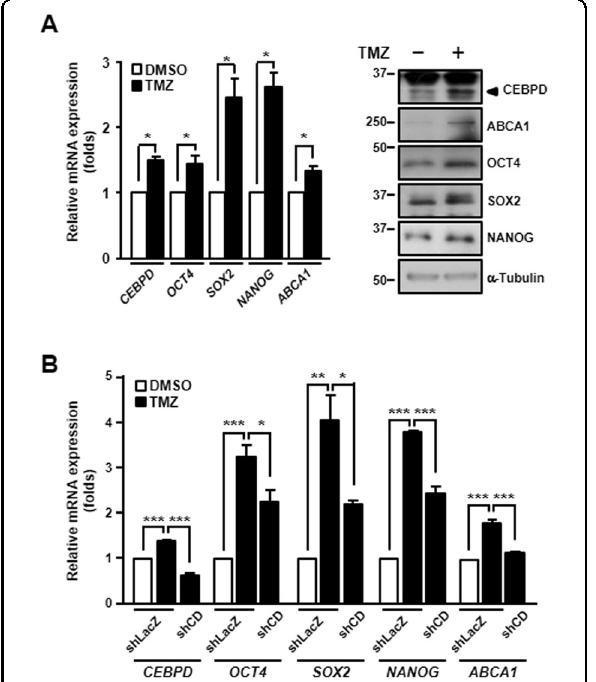
Fig. 6 CEBPD mediates SOX2 , OCT4 , NANOG , and ABCA1 upregulation in TMZ-treated GBM cells. A The expression of CEBPD, SOX2, OCT4, NANOG, and ABCA1 is increased in TMZ-treated U87MG cells. Monolayer U87MG cells were treated with 50 μ M TMZ for 6h (for RNA) or 24h (for protein). Total RNA and total protein lysates were harvested, and then, the SOX2, OCT4, NANOG, and ABCA1 transcription and expression levels were assessed by RT-qPCR and western blot. B Knockdown of CEBPD downregulates SOX2 , OCT4 , NANOG , and ABCA1 transcripts in TMZ-treated GBM cells. Knockdown of CEBPD was conducted in U87MG stable cells with IPTG for 48h, and then, the cells were treated with 50 μ M TMZ for 6h. Total RNA was harvested, and the CEBPD , SOX2 , OCT4 , NANOG , and ABCA1 expression levels were assessed by RT-qPCR. The summary data are presented as the mean ± SEM; the numbers in the bars represent the sample sizes; one-way ANOVA and Student ’ s t -test; * p <0.05, ** p <0.01, *** p <0.001.